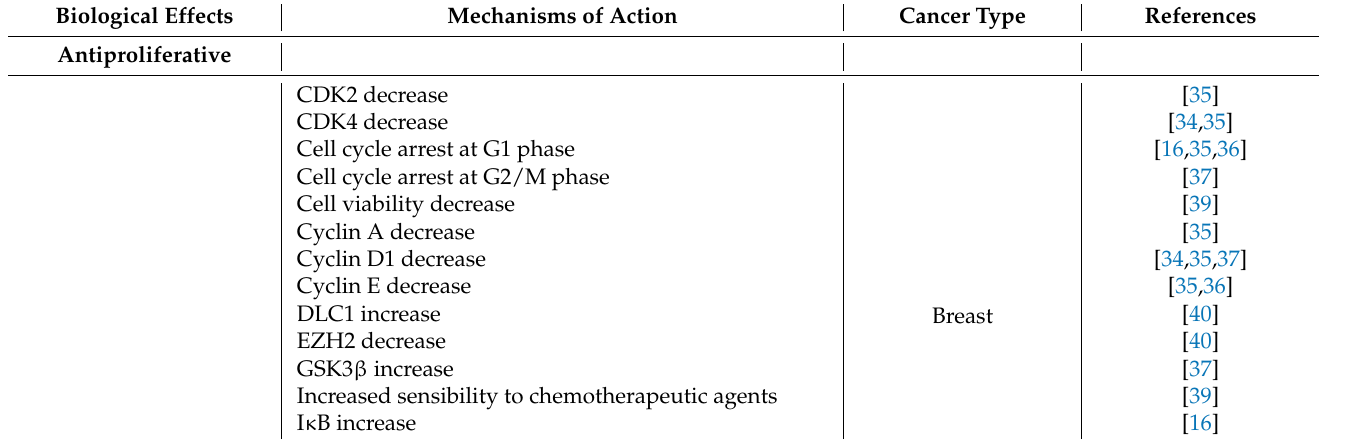
Table 1. Antitumoral activities of